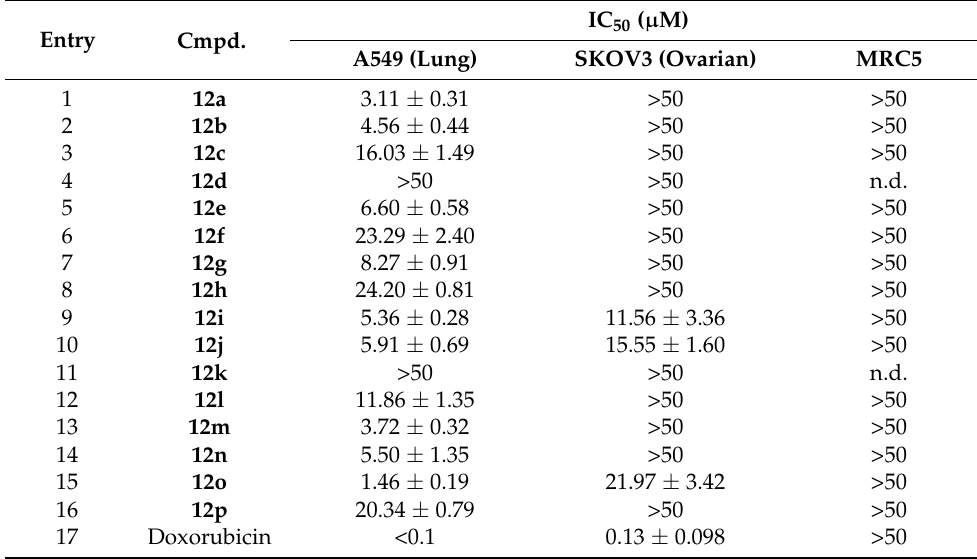
Table 3. Antiproliferative activity of 3-hydroxy γ -lactam derivatives 12